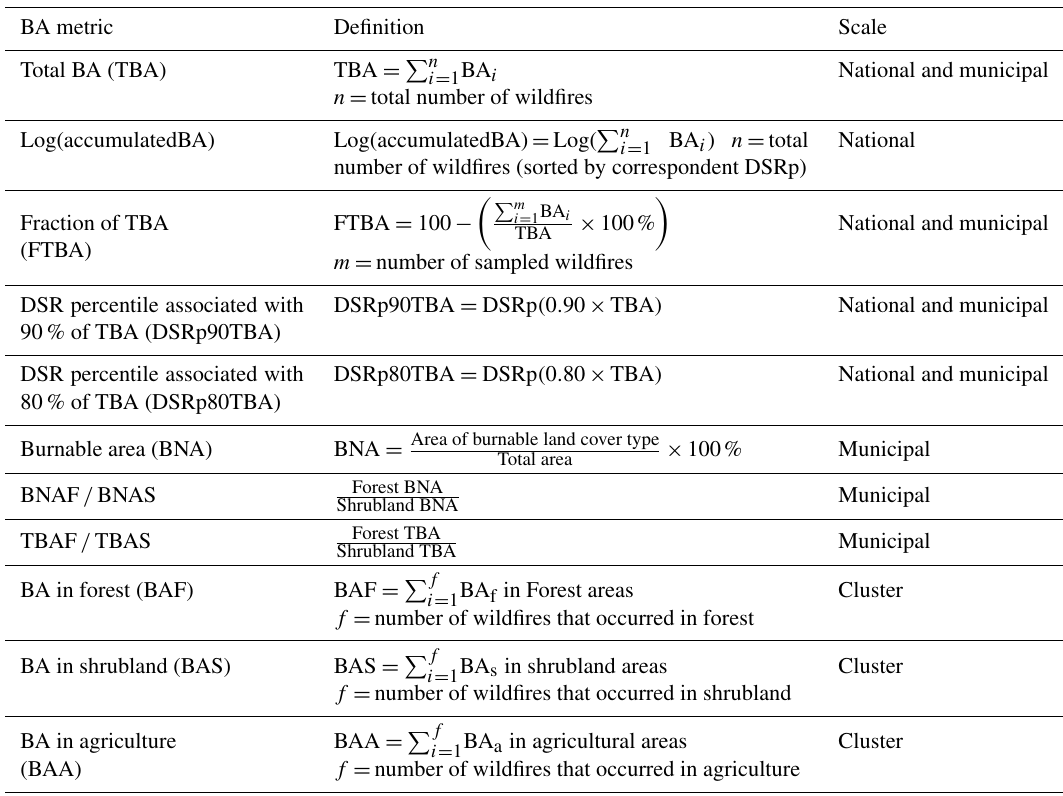
Table 2. Burnt area (BA) metrics used in the paper, including acronym, definition and spatial scale of application/use. BA